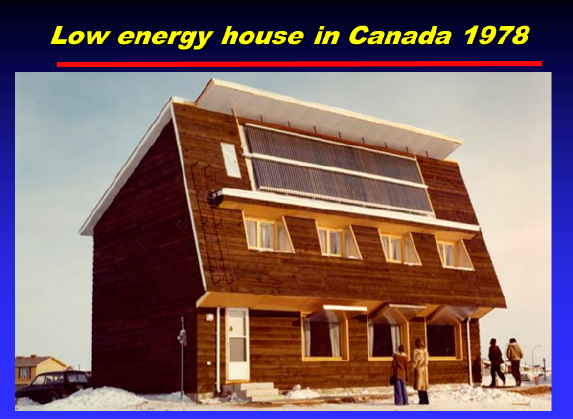
Figure 2. Saskatchewan Energy Conservation house designed by the Illinois U demonstrated passive technology in 1978 (Regina). Solar exposed surface with large windows is slightly inclined. Evacuated solar pipes are placed on the attics level. It was provided with air-sourced heat pump and polyethylene-based heat recovery ventilator. Reprinted with permission of Harold Orr.